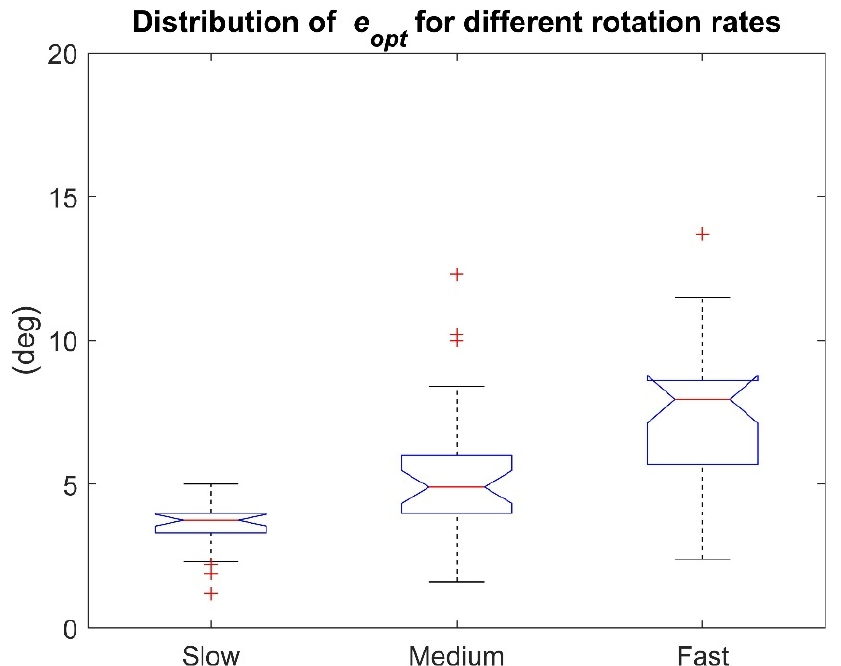
Figure 3. Rotation rate effect: slow, medium, and fast e opt distributions (10 SFAs × 3 commercial products). It is possible to assess that errors obtained at the fast rotation rate are worse than those at slow rotation rate and the three distributions statistically differ across all of them.